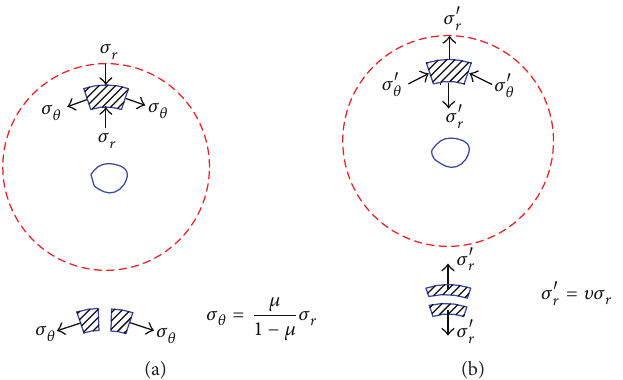
Figure 6: Formation mechanism of radial and circumferential cracks. 𝜎 𝑟 , pressure stress; 𝜎 𝜃 , circumferential tensile stress; 𝜎 󸀠 𝑟 , reflected radial tensile stress; 𝜎 󸀠 𝜃 , circumferential pressure stress.